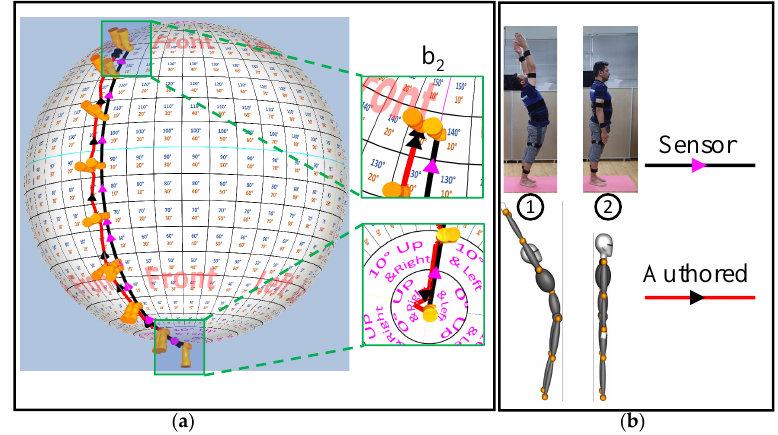
Figure 17. ( a ) Trajectories of the right upper arm ( b 2 ) for both the authored and sensor-acquired. ( b ) Key frames (1 and 2) as performed by the user and as authored on the 3D